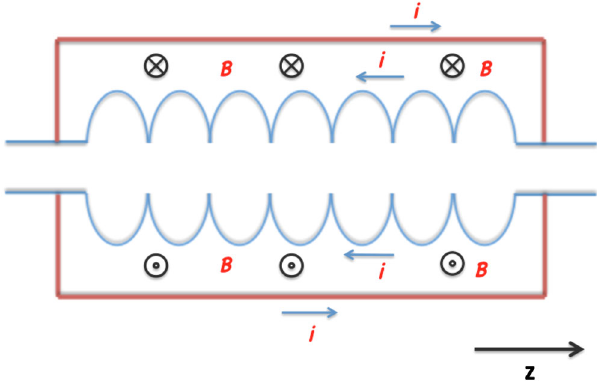
FIG. 11. Thermocurrents and associated magnetic field in the azimuthal symmetric scenario: the Seebeck induced currents i are equal, producing a symmetric magnetic